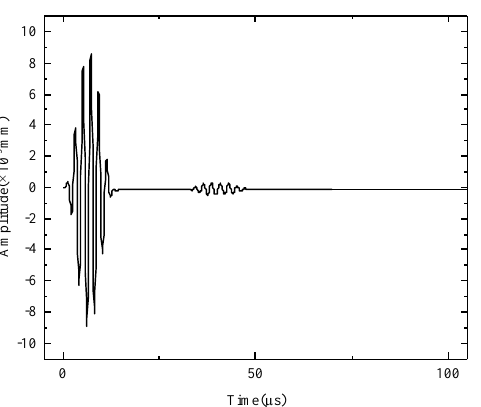
Figure 7. Time domain received signal when the maximum mesh grid is 1.2 mm. Fig. 6 Excitation signal when the grid of aluminum plate is 1.2mm